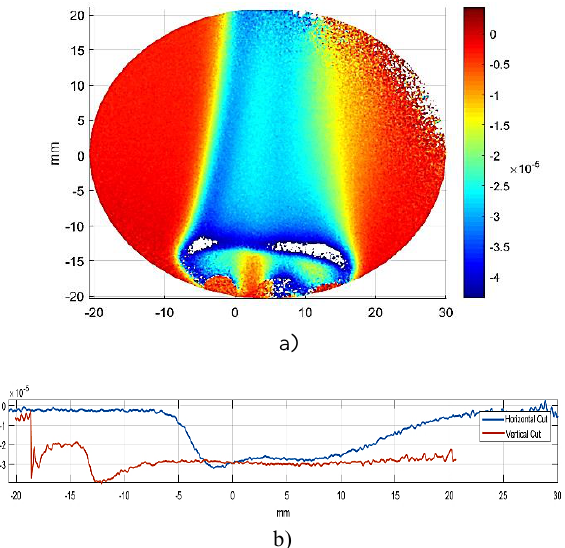
Fig.9. a) Reconstructed temperature field map 𝑇(𝑥, 𝑦) at some time instant and b) temperature profile run across the